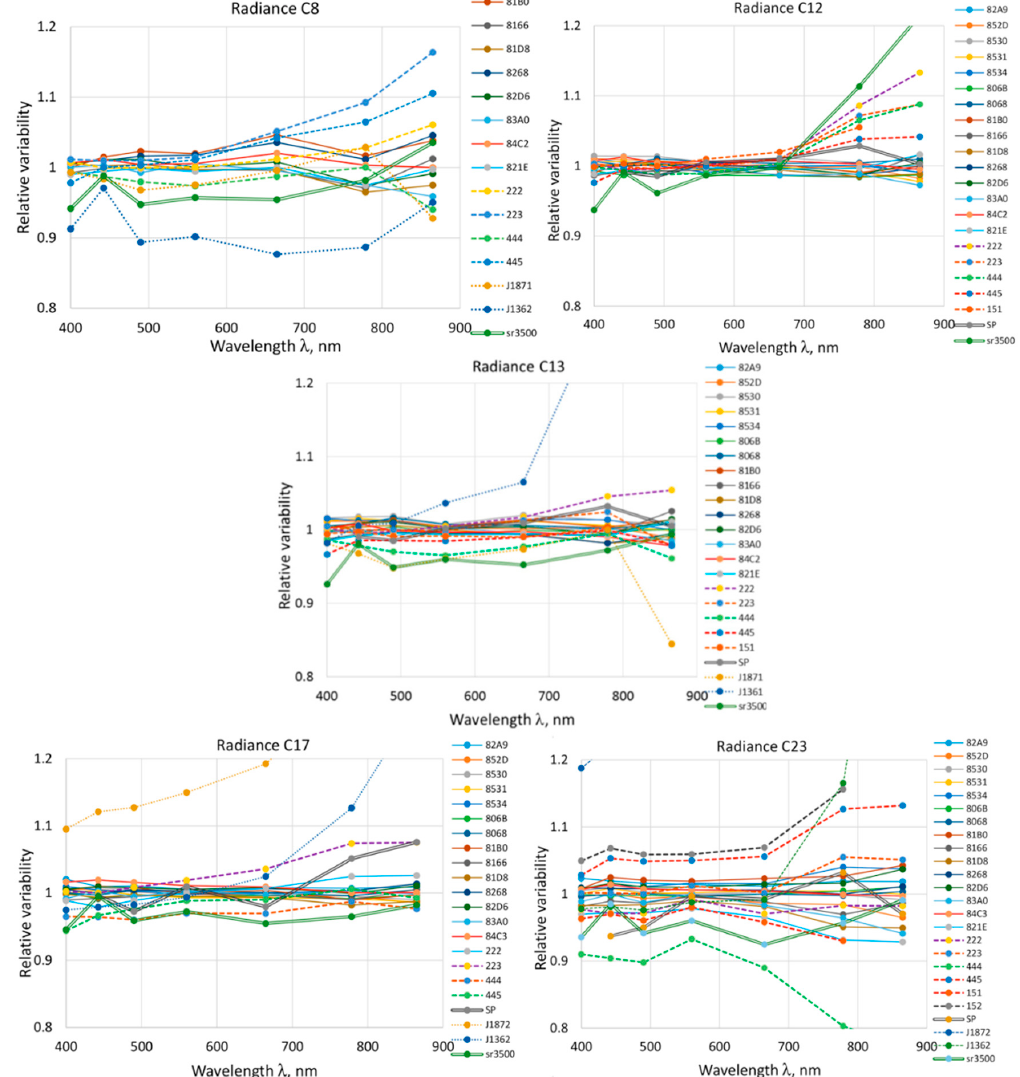
Figure 13. Radiance sensors compared to the consensus value in the outdoor experiment. C8, C12, C13—blue sky; C17—water in cloud shadow at 139 ◦ VZA; C23—sunlit water at 130 ◦ VZA. Solid lines—RAMSES sensors; dashed lines—HyperOCR sensors; double lines—SeaPRISM (SP) and SR-3500; dotted lines—WISP-3. Reproduced with permission from